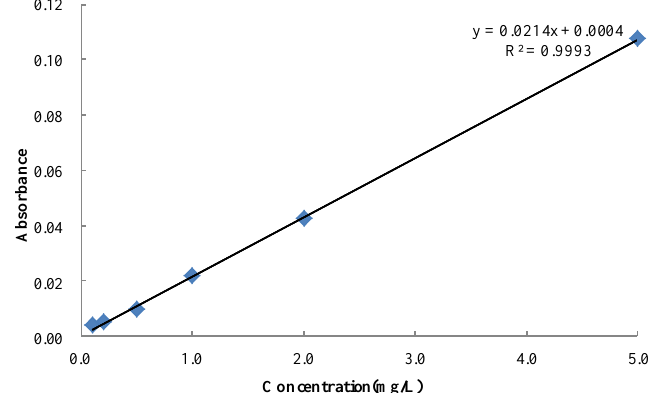
Figure 3. Standard curve of allura red Figure 3 . Standard curve of allura red solution.